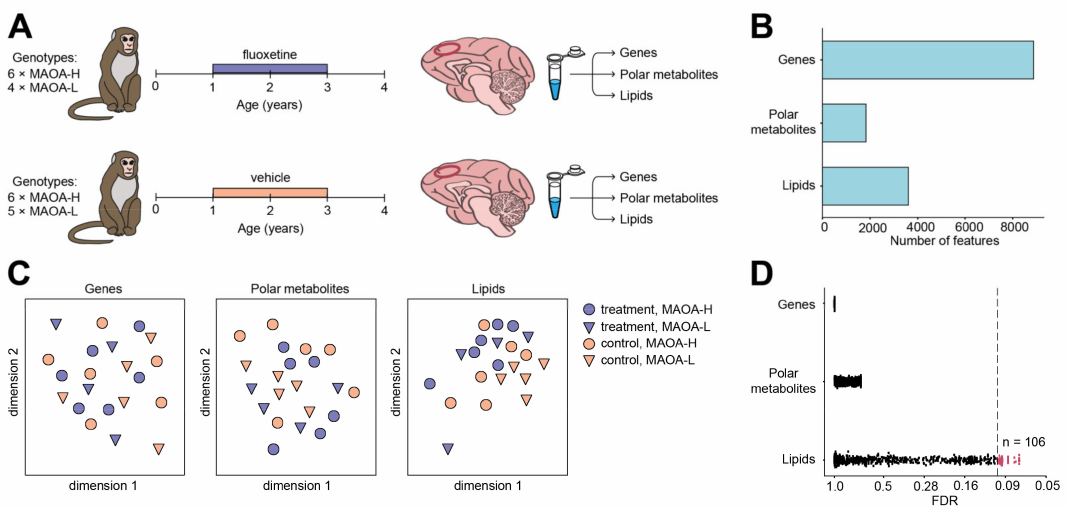
Figure 1. ( A ) Schema of experimental design. ( B ) Number of quantified genes, polar metabolites, and lipids. ( C ) Multi- dimensional scaling plots visualizing variation among samples calculated based on abundance levels of 8871 genes, 1829 polar metabolites, and 3608 lipids. Colors correspond to treatment status, shapes to the MAOA genotype. ( D ) Distribu- tion of t-test FDR values calculated for 8871 genes, 1829 polar metabolites, and 3608 lipids in the comparison between treated and control animals. Dashed line corresponds to FDR cutoff of 10%. The number of lipids passing this FDR cutoff (red) is marked on the right. The identified number of lipids passing the cutoff is greater than expected by chance (permutations, p =